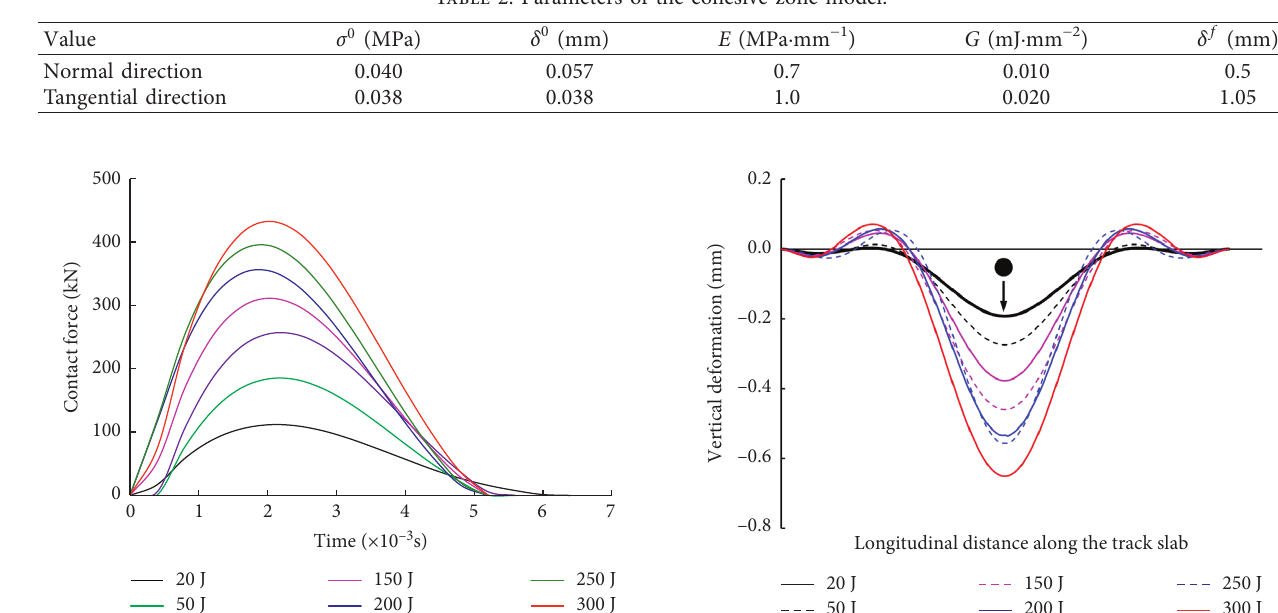
Figure 12: The maximum compression deformation for the se- lected side of the track slab for different impact energies.